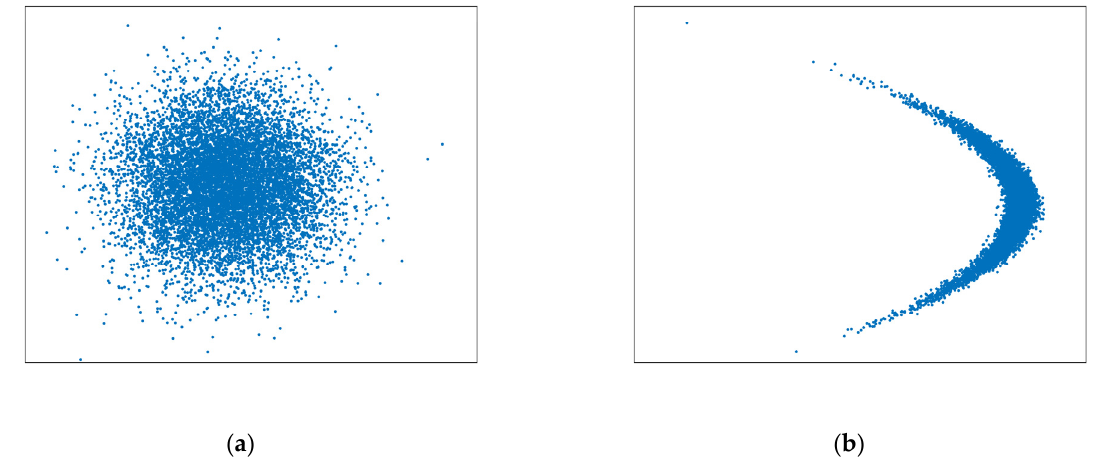
( a ) ( b ) Figure 5. Measurements Distribution: ( a ) 2 2 =0.02 ( ;200 km,(10 m) ,(0.001 rad) ) CL x β ， and ( b ) Figure 5. Measurements Distribution: ( a ) β = 0.02, CL ( x ;200 km, ( 10 m ) 2 , ( 0.001 rad ) 2 ) and 2 2 =2 ( ;200 km,(0.1 m) ,(0.001 rad) ) CL x β ， . ( b ) β = 2, CL ( x ;200 km, ( 0.1 m ) 2 , ( 0.001 rad ) 2 ) The EKF needs to linearize the measurement equation in Equation (10). Assume ( , ) x y is the position coordinate of the target relative to the Cartesian coordinate system , x y （ ） is an initial unbiased estimate of ( , ) x y 0 0